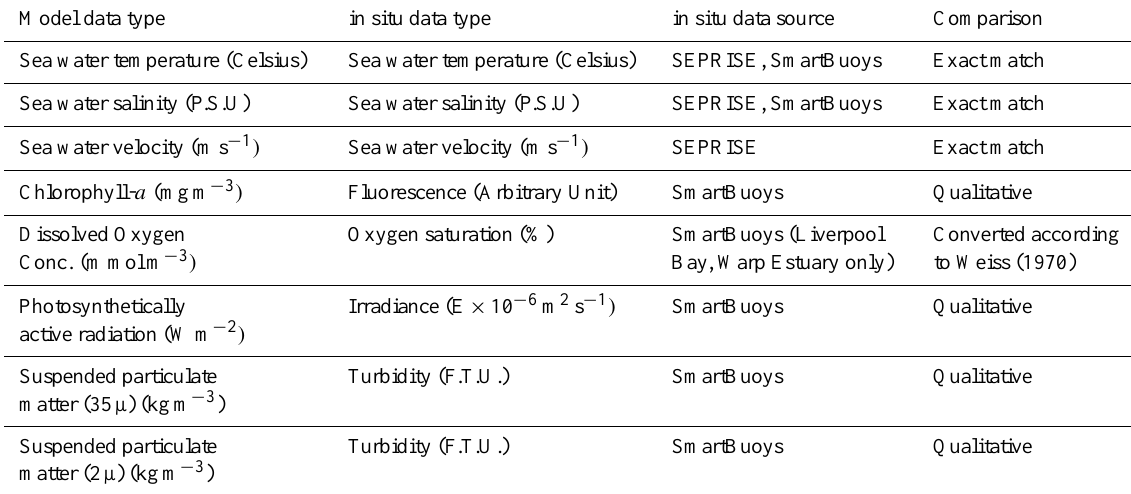
Table 2. Model data types and their corresponding in situ data types, sources, and nature of comparison. Where the comparison is given as qualitative this indicates that a dual axis plot of both data are shown, and qualitative correlations can be